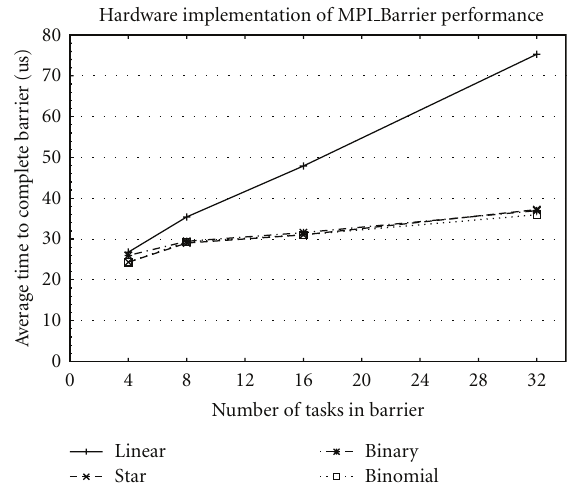
Figure 9: Measured MPI Barrier performance of di ff erent network topologies on Spirit.